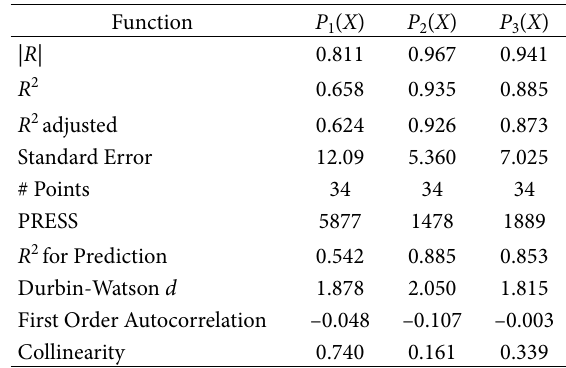
Table 2. Parameters for the model adequacy of regression equations